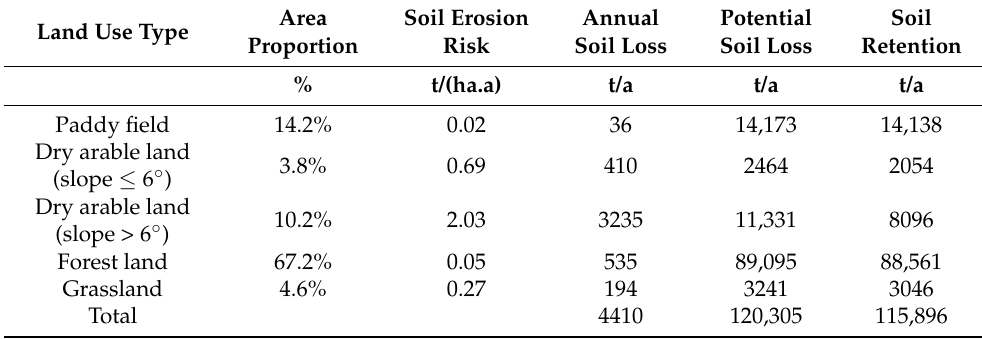
Table 3. The soil erosion of different land types in the Caidi River Watershed.